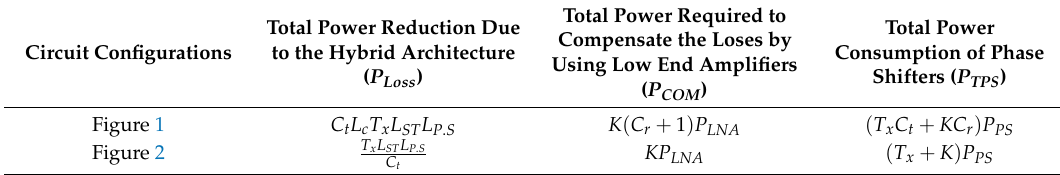
Table 1. Analytical Comparison in terms of Consumed